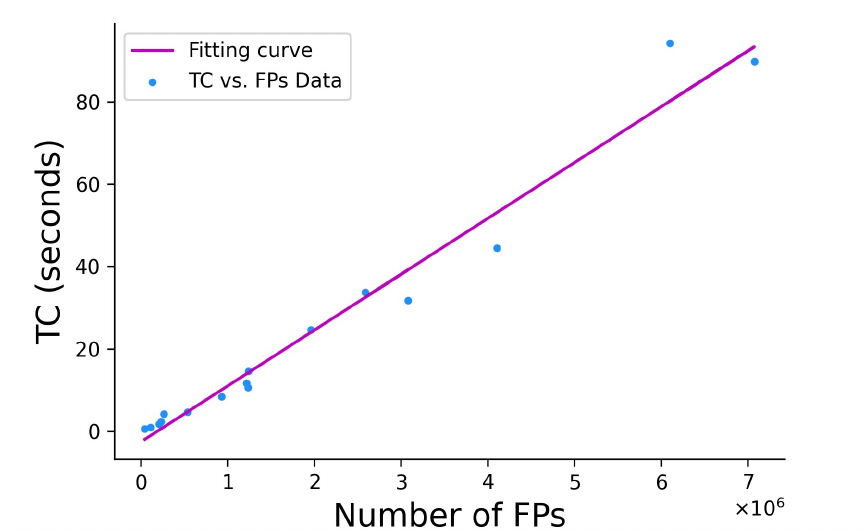
Figure 12. FPs versus TCs curve